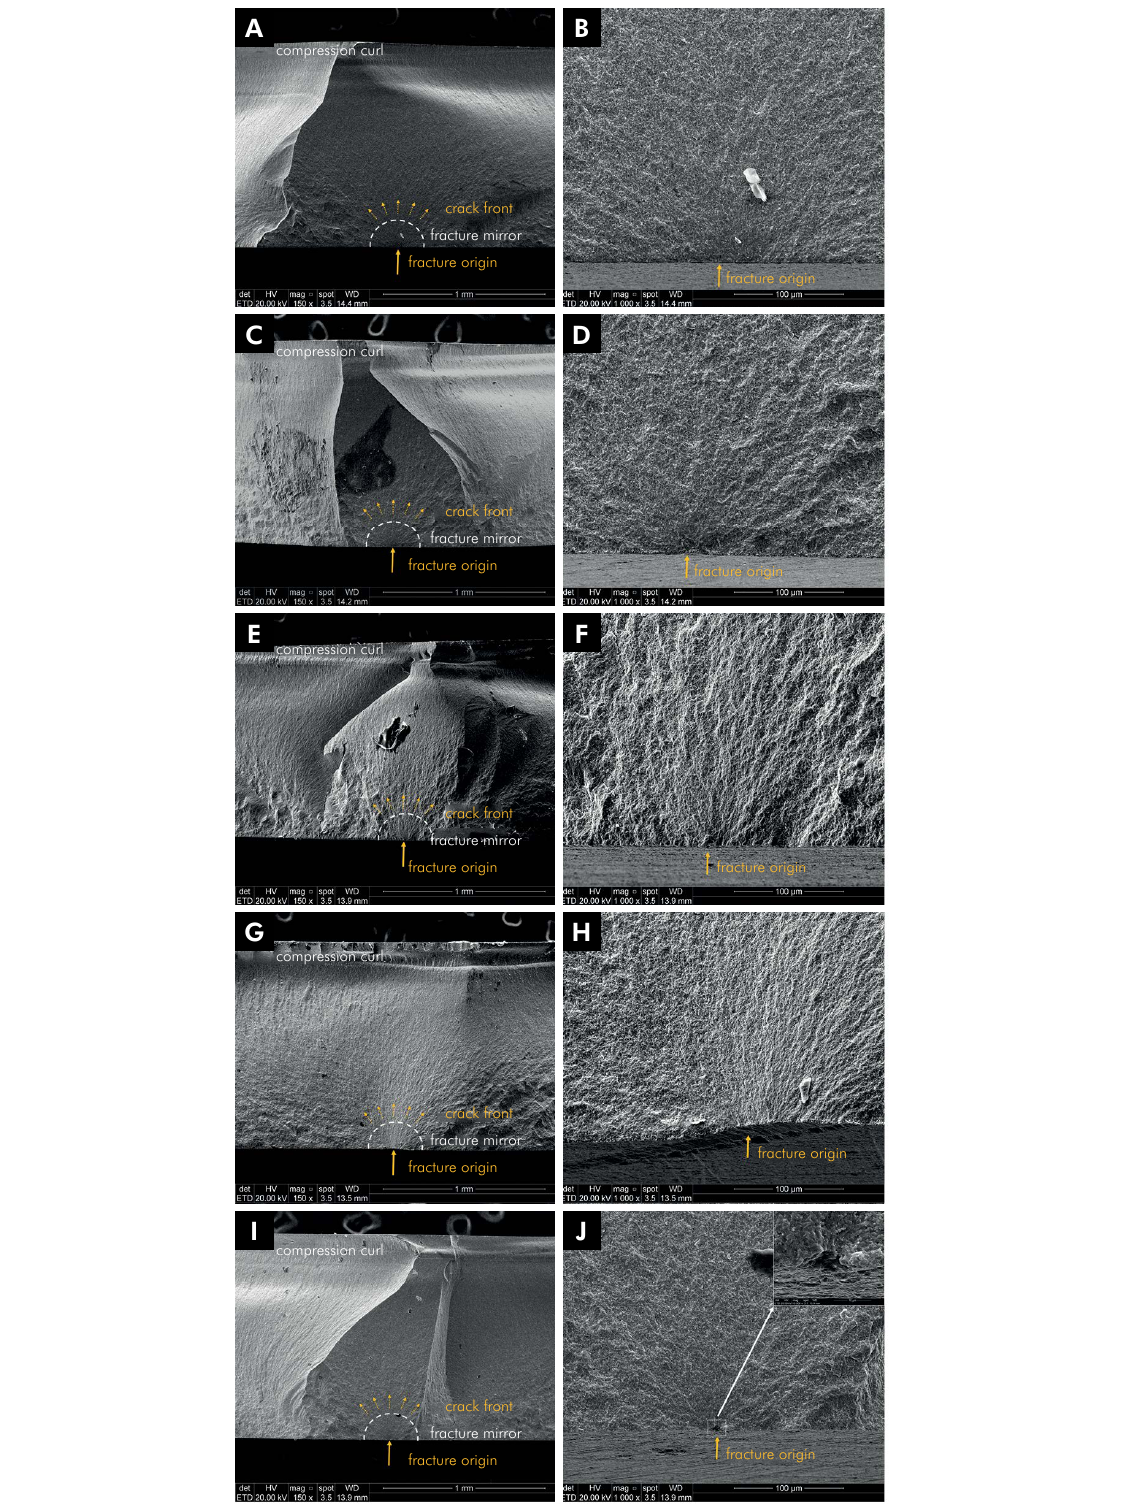
Figure 4. Fractographic analysis with FE-SEM (150 × and 1,000 × magnifications), showing typical brittle fractured surfaces, with initial crack nucleation sites located on surface defects at the region of maximum tensile stress during the biaxial tests. In the right top of the ‘J’ image, the greater magnification (10,000×) shows the defect on the crack nucleation site. A and B - CTRL group, C and D - AUT, E and F - MechLoad, G and H - AUT+MechLoad, I and J -